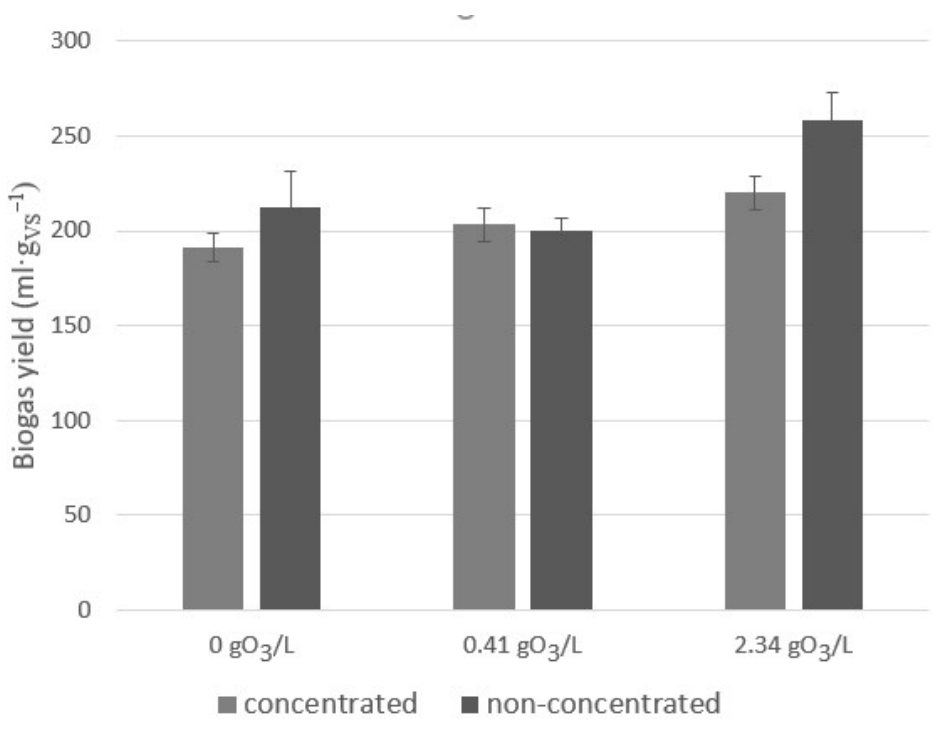
Figure 3. Biogas yield differences due to the SAS ozonation.